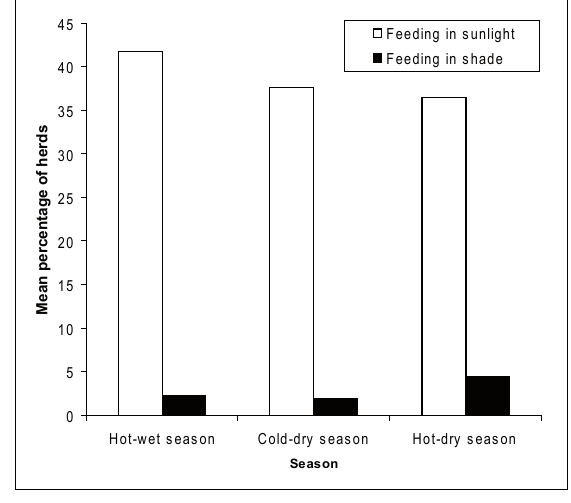
Figure 4 Mean percentage of springbok herd feeding in sunlight and shade respectively during the hot-wet, cold-dry and hot-dry seasons from November 2002 to May